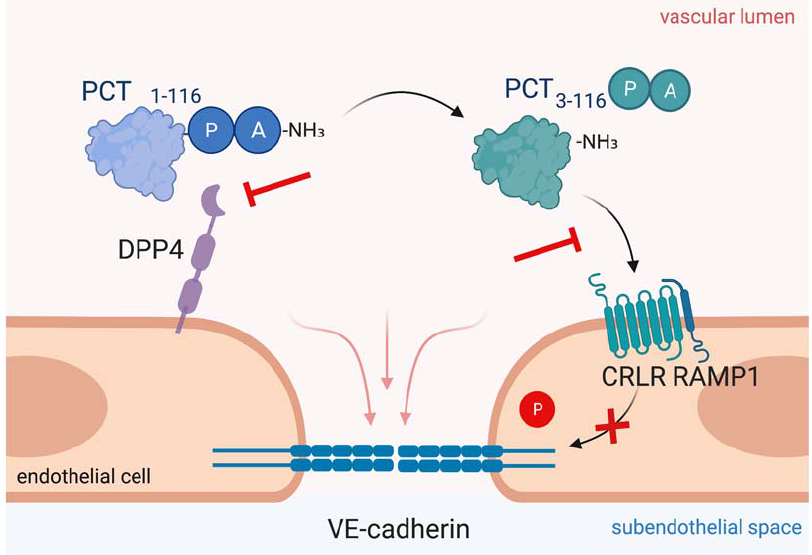
Figure 4. Targeting procalcitonin protects vascular barrier integrity during hyperprocalcitonemia in systemic inflammation. Dipeptidyl peptidase 4 (DPP4) mediates N-terminal truncation of full-